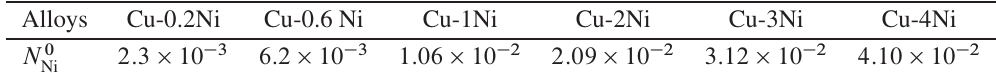
D mole fraction of Ni). Ni